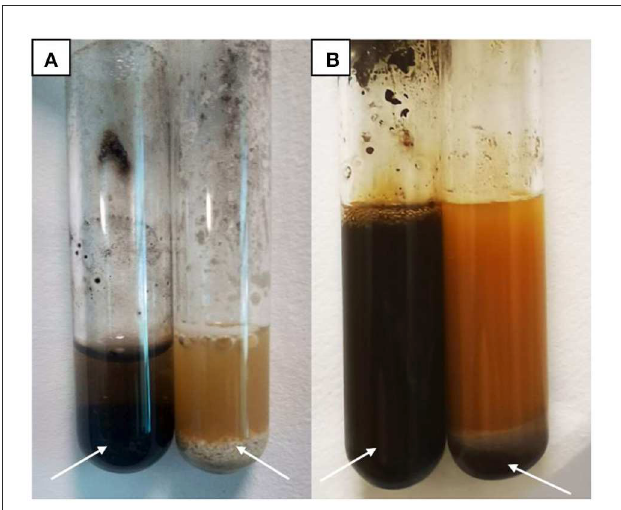
FIGURE4 Urine Chemistry Test. (A) Model group (left) and control group (right). (B) Model group (left) and treatment group (right).